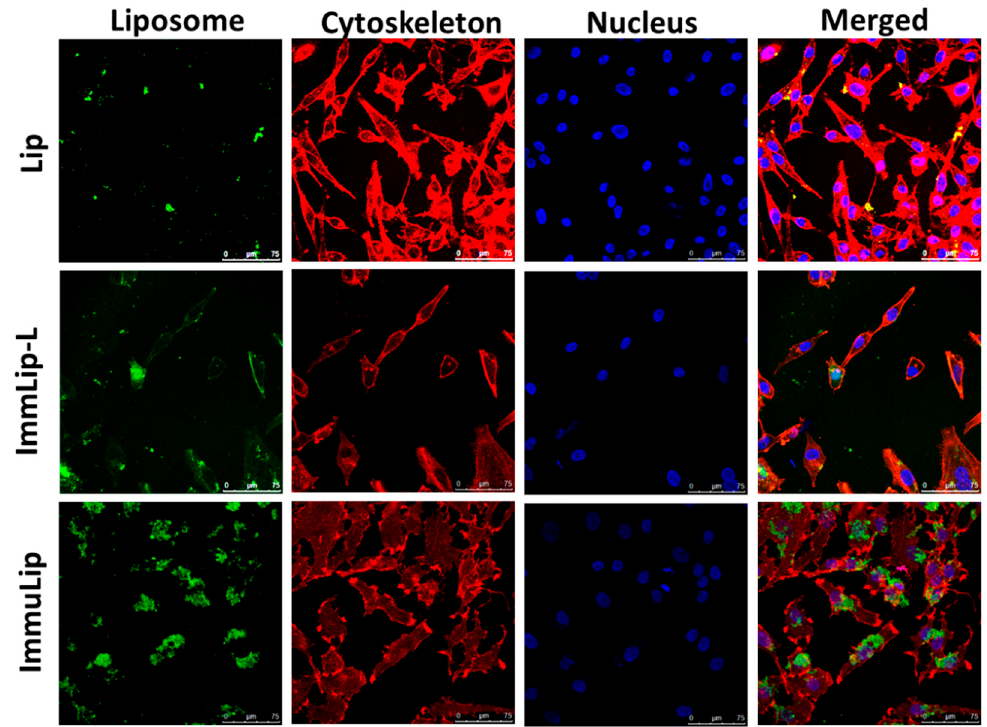
Figure 4. The intracellular uptake of liposomes (Lip), immunoliposomes (ImmuLip) and Figure4. Theintracellularuptakeofliposomes(Lip),immunoliposomes(ImmuLip)andimmunoliposomes immunoliposomes prepared with 1/4 of anti-GD2 Ab used for ImmuLip (ImmuLip-L) by U87DR cells prepared with 1 / 4 of anti-GD2 Ab used for ImmuLip (ImmuLip-L) by U87DR cells in 24 h from confocal in 24 h from confocal laser scanning microscopy analysis (bar = 75 µm). Liposomes were labelled with laser scanning microscopy analysis (bar = 75 µ m). Liposomes were labelled with 5(6)-carboxyfluorescein N-hydroxysuccinimide ester (green), cytoskeleton labelled with phalloidin-tetramethylrhodamine